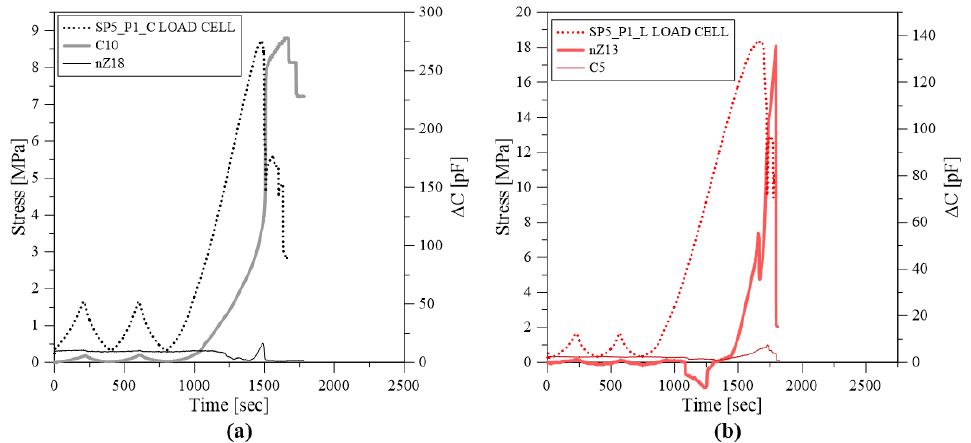
Figure 14. Comparison between measurements provided by ceramic and capacitive sensors and the load cell data for post-installation system P1: ( a ) calcarenite masonry; ( b ) clay brick